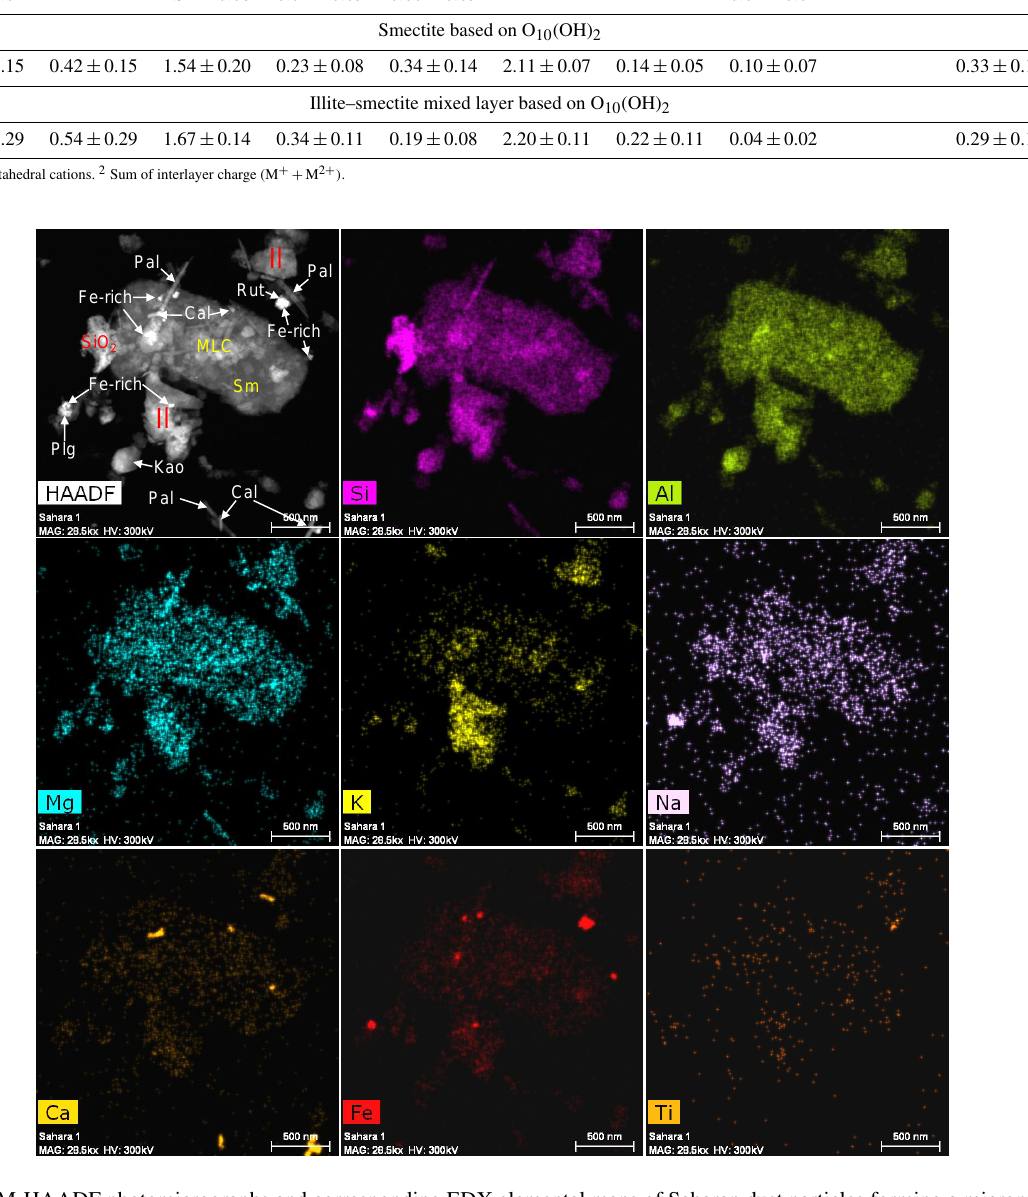
Figure 7. STEM-HAADF photomicrographs and corresponding EDX elemental maps of Saharan dust particles forming a micrometer-sized aggregate. Based on the compositional analysis, particles of palygorskite (Pal), calcite (Cal), iron oxyhydroxides (Fe-rich), rutile (Rut), illite (Il), smectite (Sm), kaolinite (Kao), silica (SiO 2 ), which according to SAED results is amorphous (i.e., diatoms), plagioclase (Plg), and mixed-layer clays (MLC) were